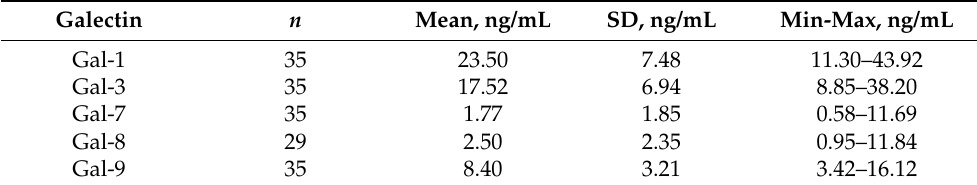
Table 1. Breast Cancer Patient Serum Galectin Levels.